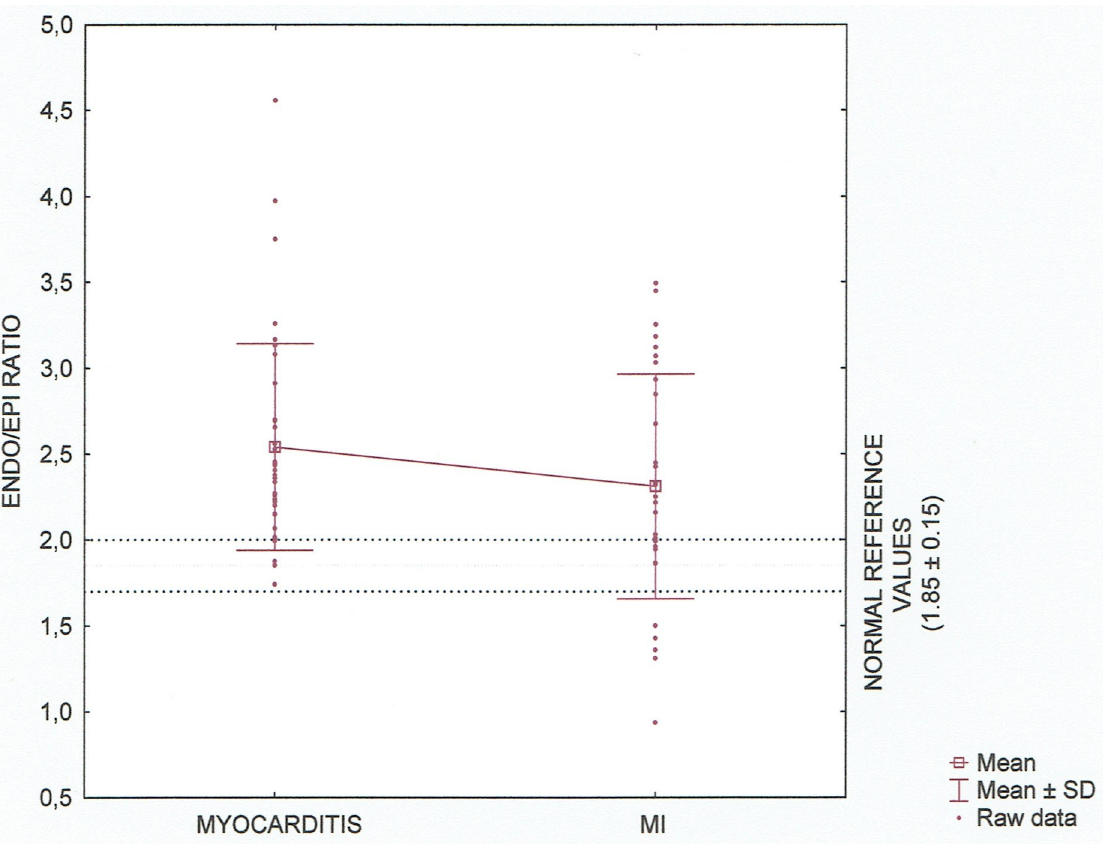
Fig 1. Layer–specific circumferential strain (Endo/Epi ratio) in the myocarditis and MI groups. Data are shown as Tukey boxplot and raw data, taking into account normal references values for age, p = 0.144.